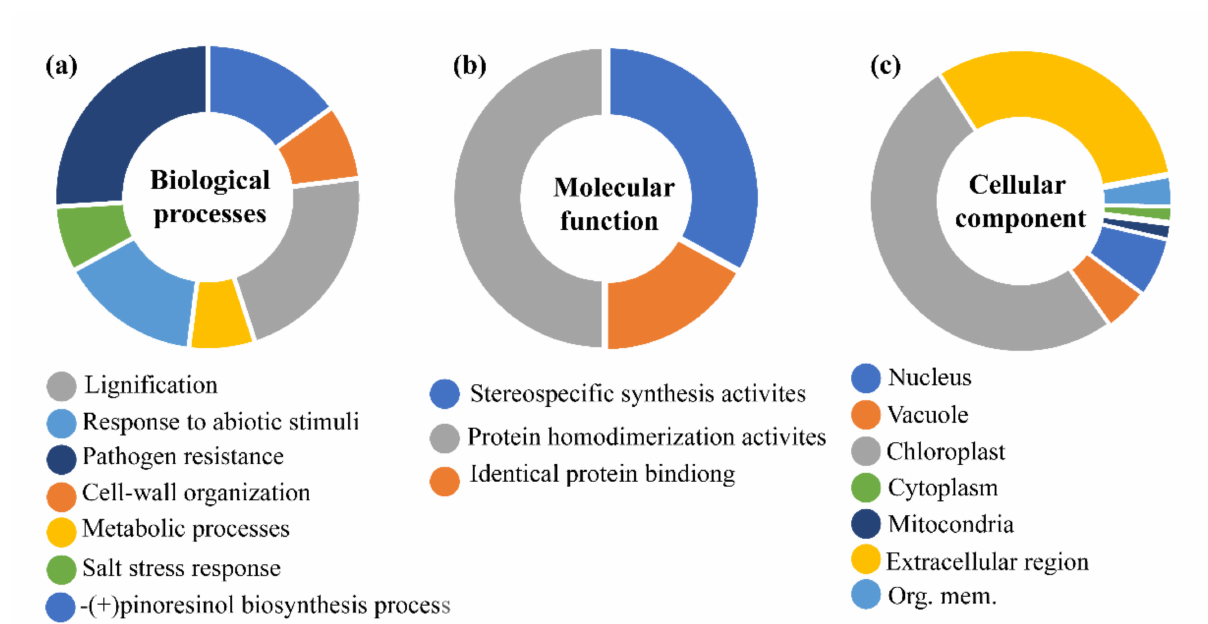
Figure 4. Gene ontology analysis of DIR proteins in different categories. Blast2Go program was utilized to present the biological ( a ), cellular ( b ), and molecular functions ( c ) of different DIR protein in Citrullus lanatus , Cucumis melo and Cucumis sativus . Different colors which are indicated near the pie-charts show functions in different